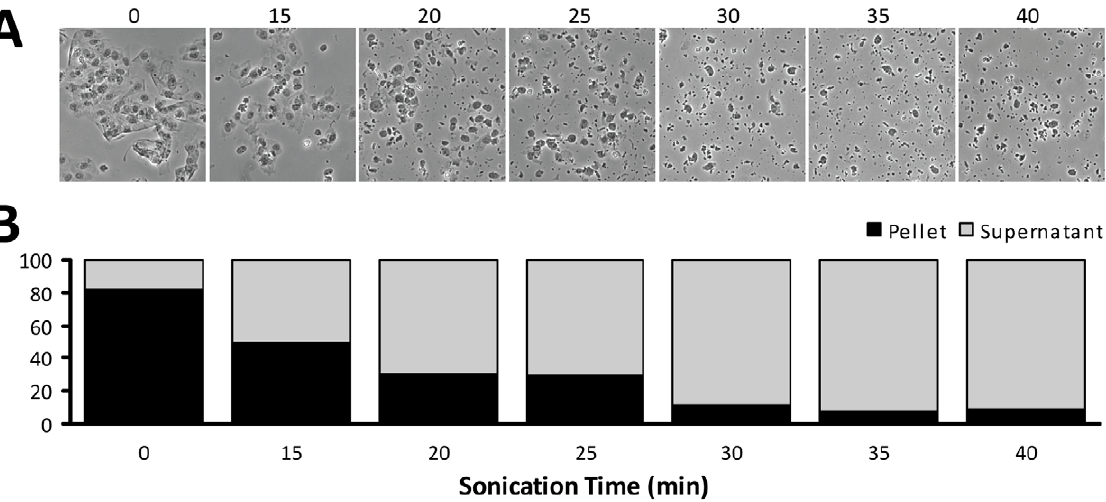
Figure 3. Effect of Sonication Time on Cell Integrity and DNA Recovery from Human VEC. Fixed vascular endothelial cells (VEC) suspended in IP + PPI buffer were spotted onto slides (2.5 m l) before sonication (0 min), or after being sonicated for 15 – 40 min at 300 W ( A ). Samples were viewed with phase-contrast light microscopy; images were captured using QCapture Pro51 imaging software (Magnification: 100X). DNA was extracted via PCIA; concentrations were determined using a NanoDrop then graphed as a percentage of the total recovered per sonication time point ( B ). Large sheets of intact VEC were present in the unsonicated sample (0 min). As sonication time increased, cell integrity decreased coincident with an increase in DNA recovered from the sample supernatant. After 30 min of sonication, the cell nuclei appeared to be pulverized; sonication at 35 and 40 min had no additional affect on the visual appearance of the sample and increased the recovery of DNA by only 2%.